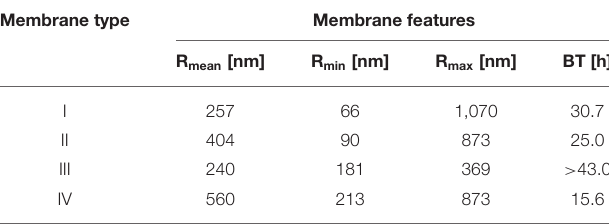
TABLE 1 | Breakthrough time, BT, of modules equipped with the investigated membranes as a function of their mean, R mean , minimal, R min , and maximal, R max , pore